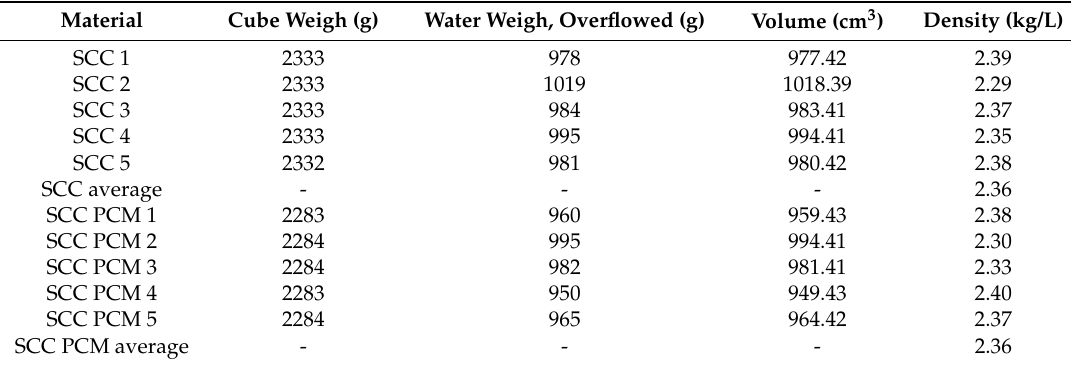
Table A2. Experimental data obtained for density determination.